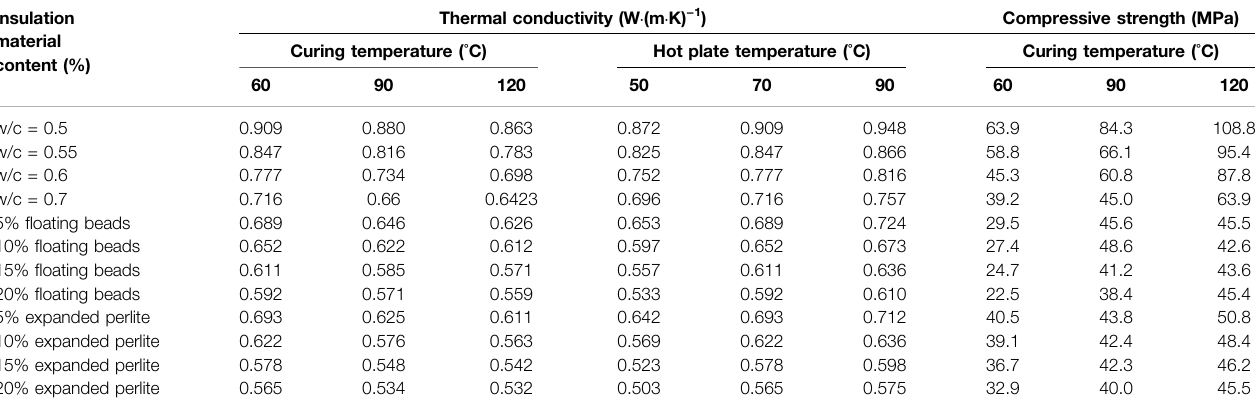
TABLE 4 | Thermal conductivity and compressive strength of cement. Insulation material